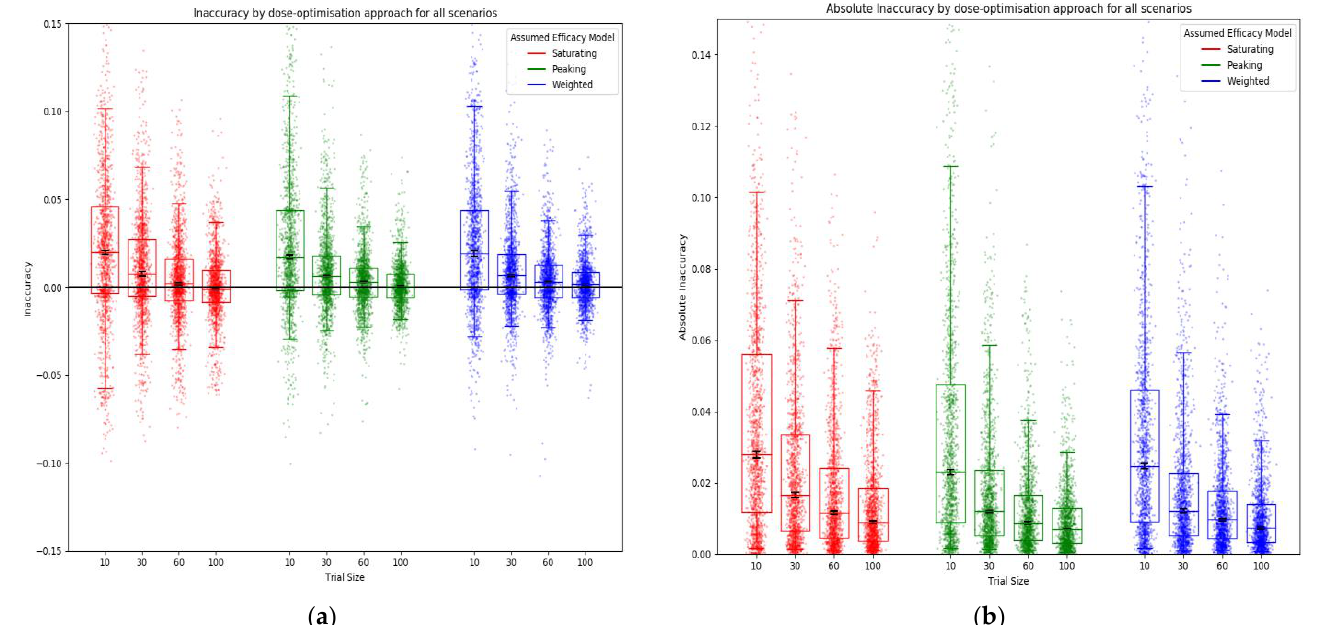
Figure 8. Inaccuracy ( a ) and absolute inaccuracy ( b ) for all scenarios by assumed efficacy model and trial size. Trial dose-selection method was full uniform exploration. The closer the inaccuracy/absolute accuracy was to 0, the more accurate the prediction of utility was at the predicted optimal dose. Individual points represent inaccuracy/absolute inaccuracy for a single simulated clinical trial using that dose-optimisation approach for one of the 14 scenarios. The middle line of each boxplot is the median value; the box marks the 25th and 75th percentiles, and the whiskers mark the 5th and 95th percentiles of the data. Black lines represent the 95% confidence interval for the median of each distribution [47]. The majority of these distributions of absolute inaccuracy were different to a statistically significant extent at the p = 0.05 threshold according to the Kolmogorov – Smirnov test due to the large number of simulations conducted (100 per approach/scenario pairing). For further details on statistical significance, see Supplementary S12.